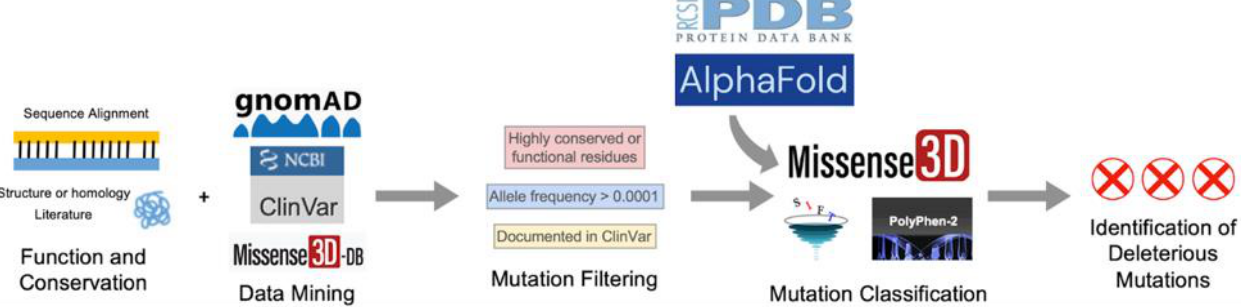
Figure 2. Schematic diagram of the overall approach used in this study.